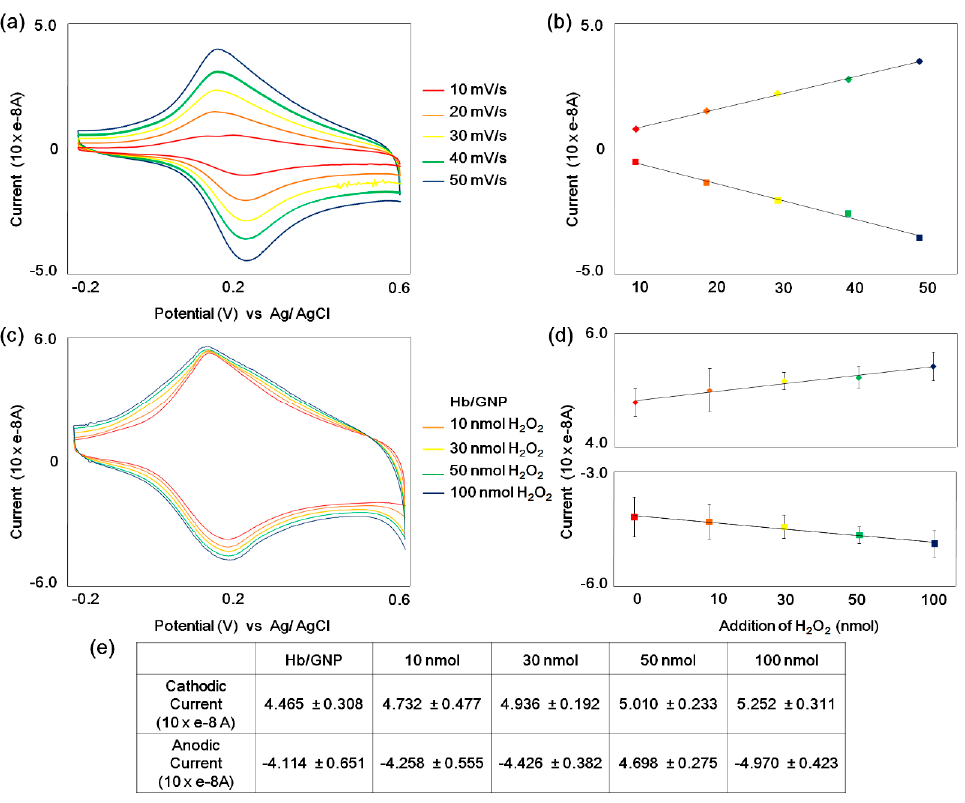
Figure 5. ( a ) Cyclic voltammogram of hemoglobin/gold nanoparticle (Blue line) immobilized on Au micro-gap electrode in 10 mM PBS (pH = 7.4) at different scan rate (mV/s) (Red line: 10 mV/s, Orange line: 20 mV/s, Yellow line: 30 mV/s, Green line: 40 mV/s, Blue line: 50 mV/s); ( b ) Plots of anodic and cathodic peaks currents vs. scan rates; ( c ) Cyclic voltammogram of hemoglobin/gold nanoparticle (Blue line) immobilized on Au micro-gap electrode containing (Red line: 0, Orange line: 10 nmol, Yellow line: 30 nmol, Green line: 50 nmol, Blue line: 100 nmol H 2 O 2 at 50 mV/s); ( d ) Plots of anodic and cathodic peaks currents vs. addition of H 2 O 2 ; ( e ) Table of current values corresponding to H 2 O 2 concetrations.